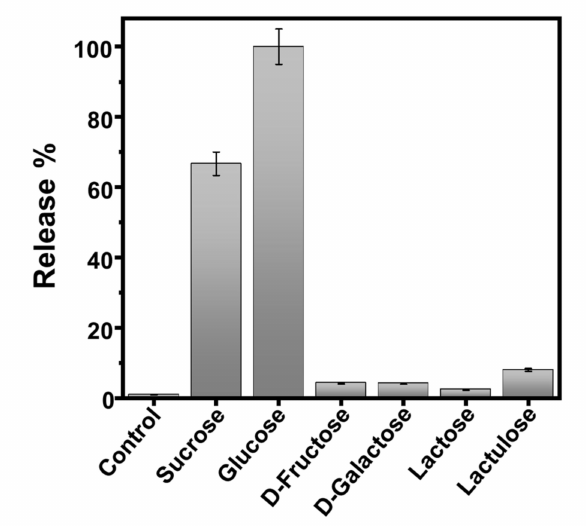
Figure 5. Effect of the presence of different sugars to the communication system’s established chemical response. (Conditions: 20 mM Na 2 SO 4 , pH 7.5, 25 ◦ C, [J1c] = 3 mg mL − 1 , [J2c] = 3 mg mL − 1 , λ abs = 454 nm). Error bars correspond to the s.d. from three independent